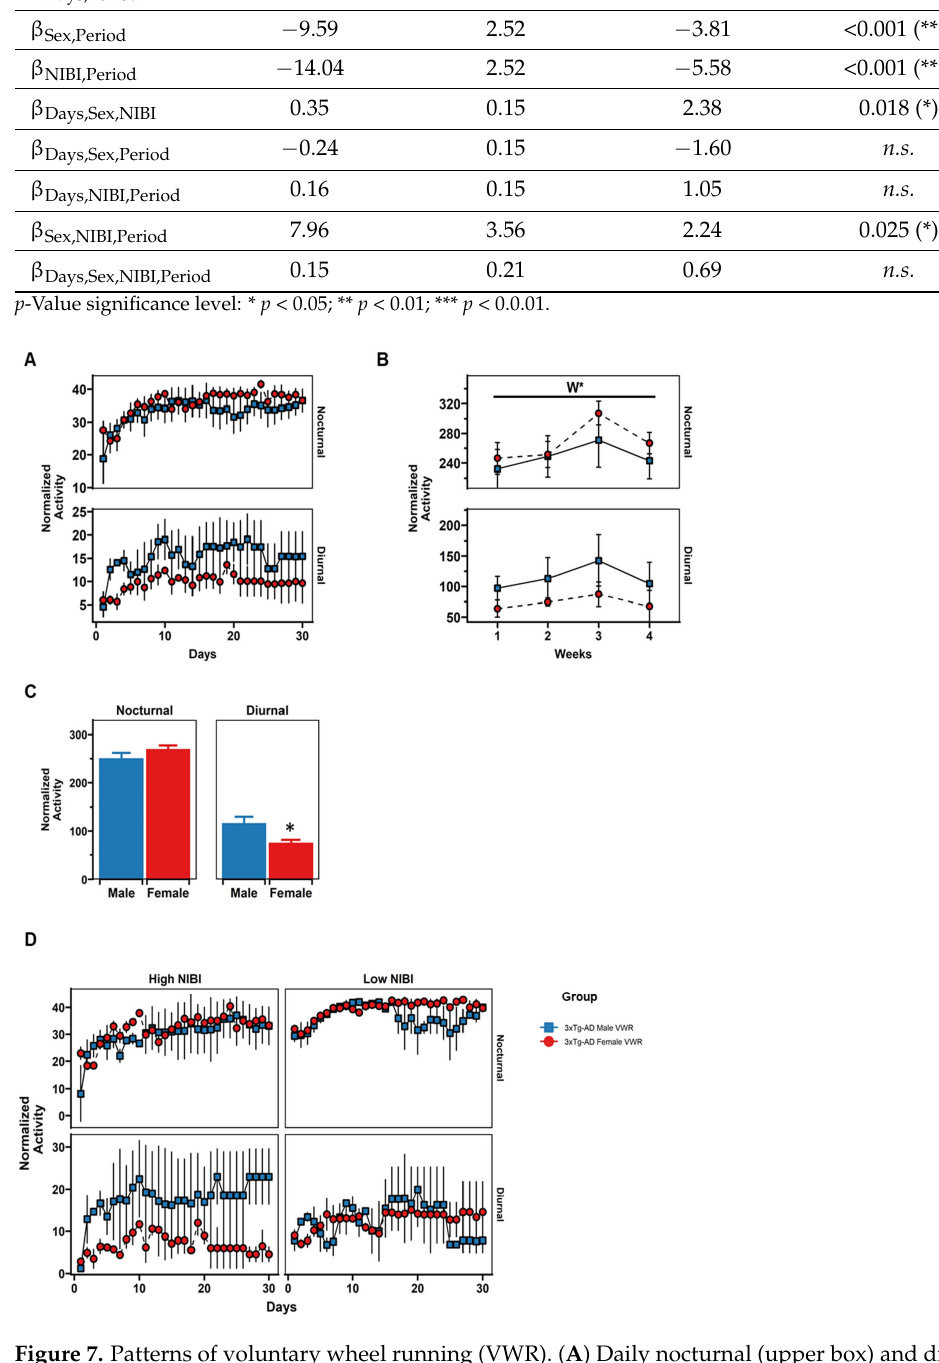
Figure 7. Patterns of voluntary wheel running (VWR). ( A ) Daily nocturnal (upper box) and diurnal (lower box) VWR activity. ( B ) Mean total activity in the RW week by week during nocturnal (upper box) and diurnal (lower box) periods. ( C ) Mean total activity per week during nocturnal and diurnal periods. ( D ) Activity in the RW adjusted by high and low novelty-induced behavioral inhibition (NIBI) in the corner test (CT) at baseline. W, weeks effect; * p < 0.05 and t -test vs. sex counterpart in the same